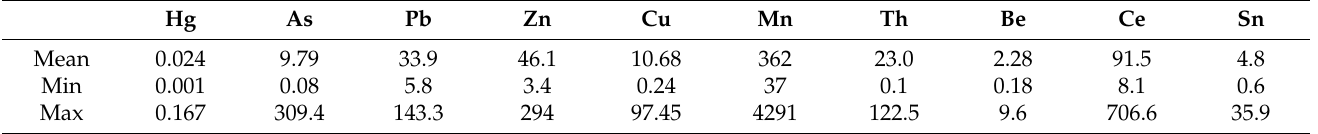
Table 1. Results of the indicators in the solid samples (unit: mg/kg).